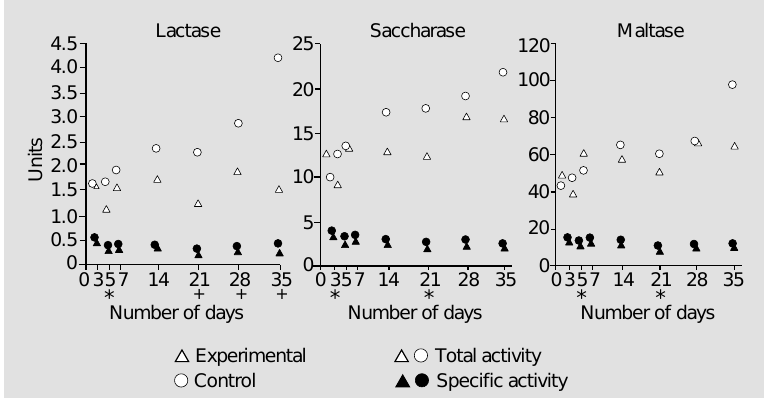
Figure 1 - Median total and specific lactase, saccharase and maltase activities in experimen- tal and control animals on the 3rd, 5th, 7th, 14th, 21st, 28th and 35th days of the experiment. *P<0.05 when total activity was compared (Mann-Whitney U-test); + P<0.05 when total and specific activities were compared (Mann-Whitney